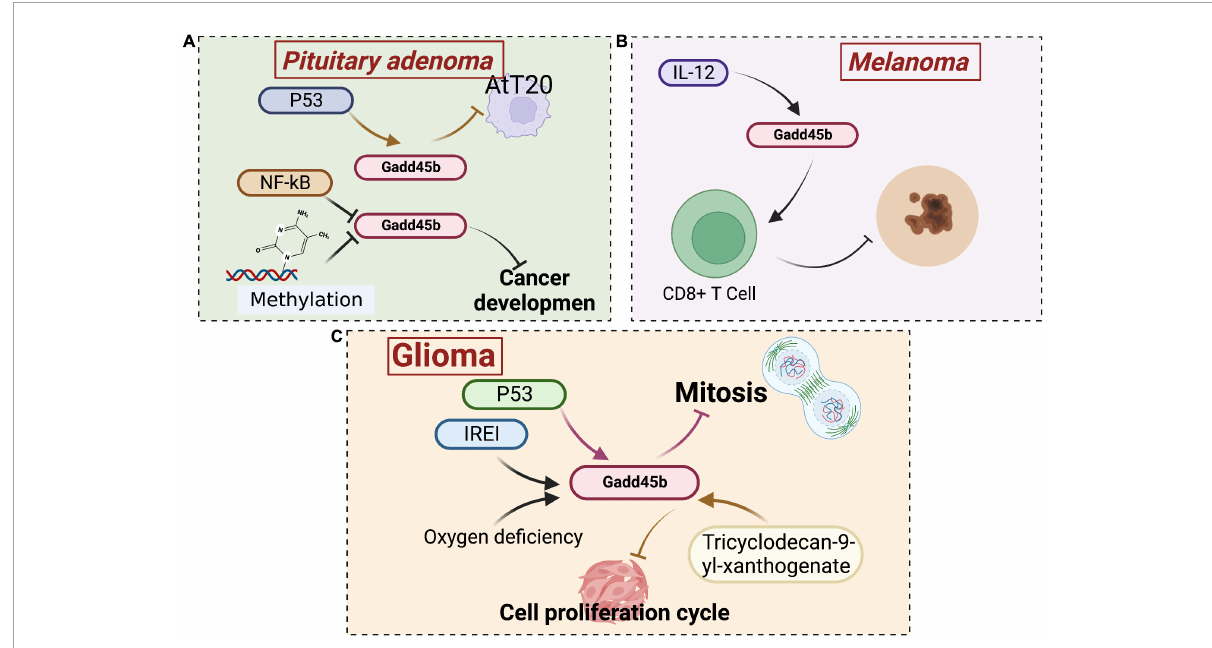
FIGURE8 Roles of growth arrest and DNA damage-inducible beta (Gadd45b) in brain tumor. (A) Gadd45b is associated with NF-kB and P53 signaling pathways inhibiting pituitary adenoma cell growth. (B) The inhibitory effect of Gadd45b on melanoma growth is associated with IL-12. (C) The inhibitory effect of Gadd45b on glioma growth may be related to P53, IREI, and Tricyclodecan-9-yl-xanthogenate (Figure was created with